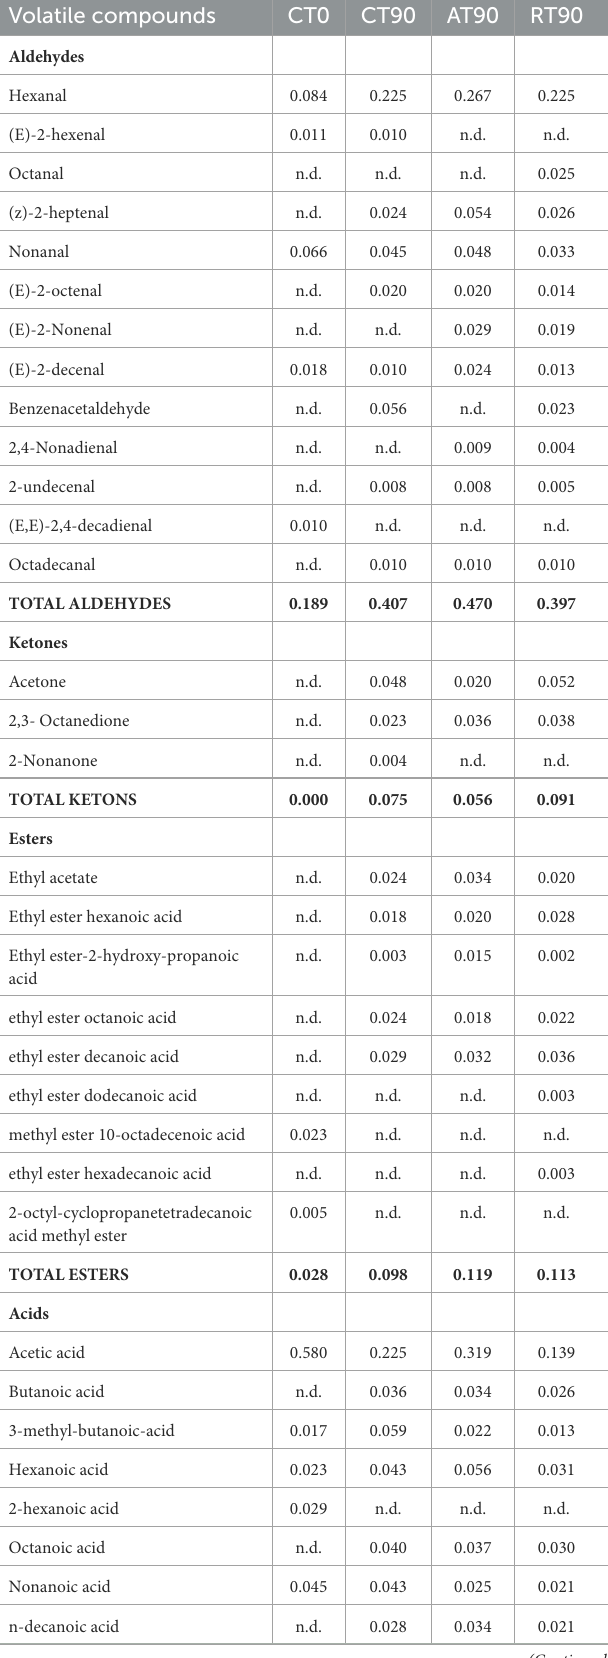
TABLE 1 Volatile compounds (mg/kg) identified at the end of ripening (90 days) in the different assay. Volatile compounds CT0 CT90 AT90 RT90